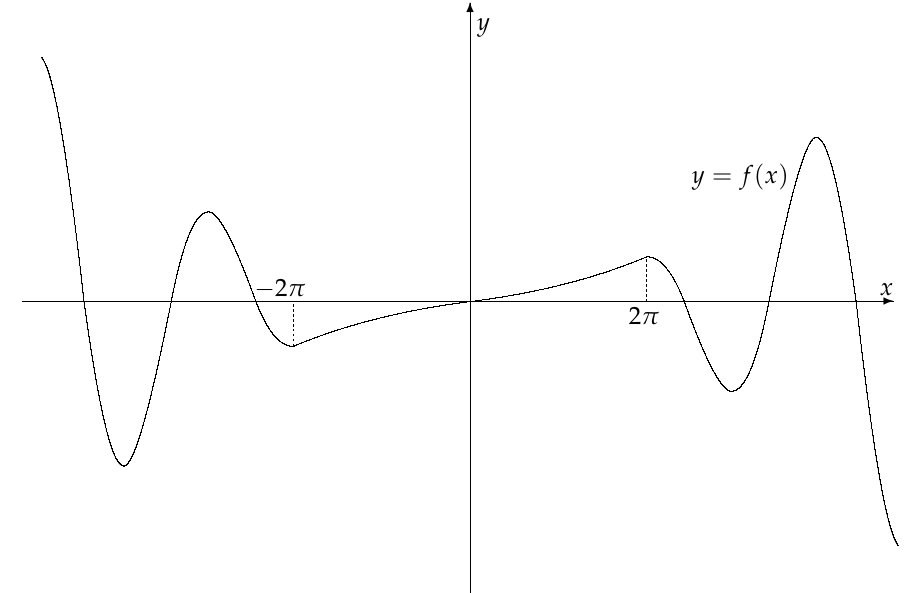
Figure 1. Function f ( x ) from Example 1 (with τ ( z ) = 1.5 and p ( z ) =